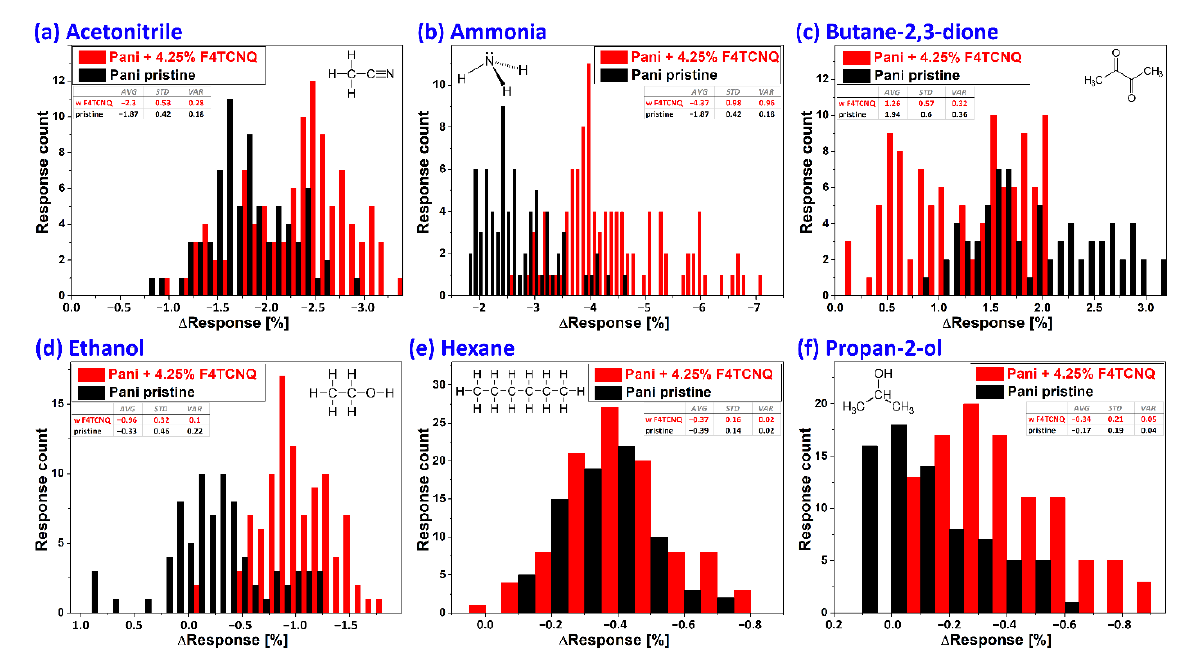
Figure 4. Histogram (bin sizes 0.1%) comparison of sensor responses to six different analytes with pristine polyaniline films (black bars) and PANI films doped with 4.25 wt% F4TCNQ (red bars). ( a ) Acetonitrile responses; ( b ) ammonia; ( c ) butane-2,3-dione; ( d ) ethanol; ( e ) hexane; and ( f ) propan-2-ol.